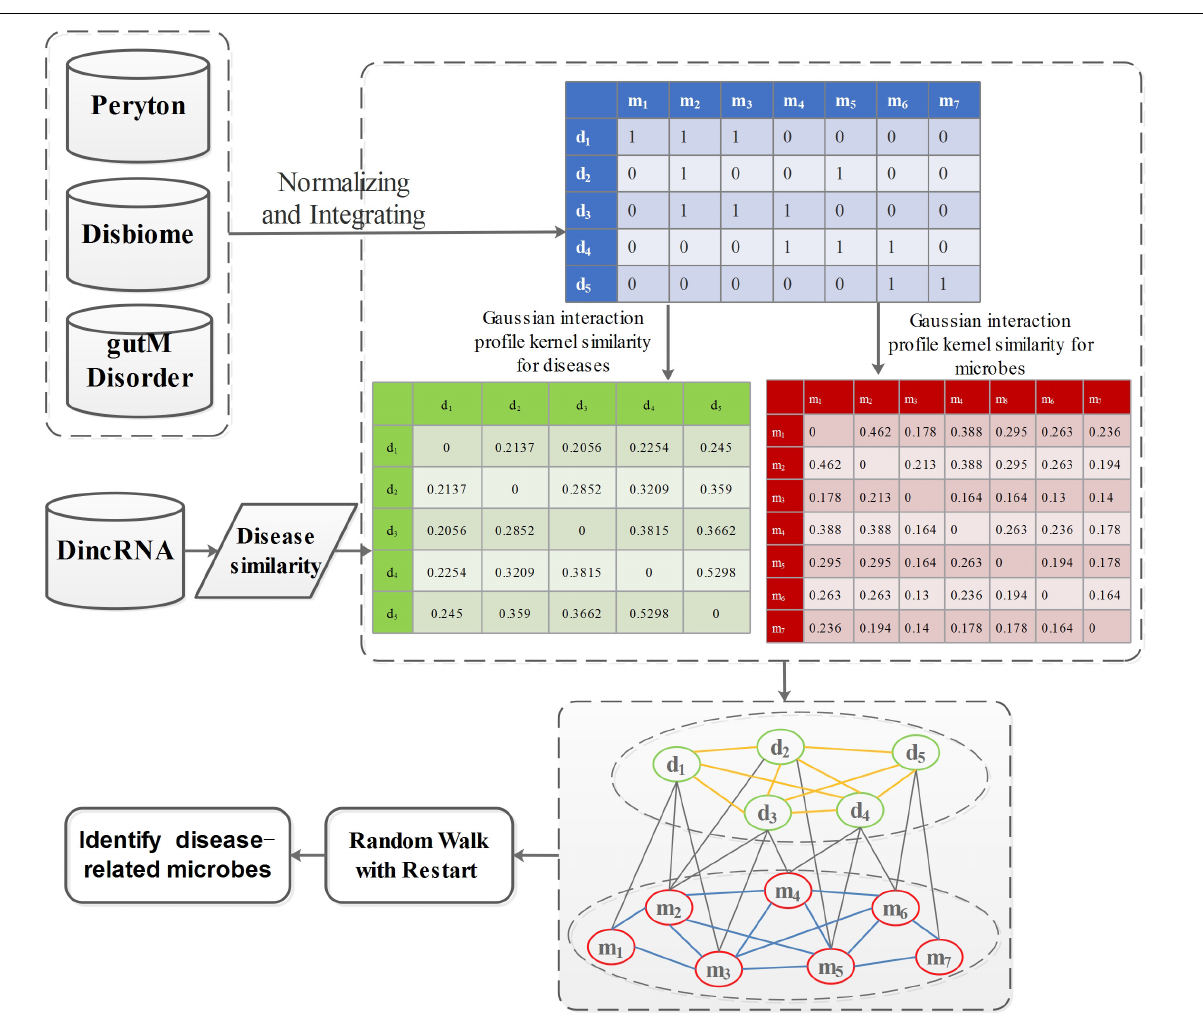
FIGURE 2 | The flowchart of prioritization of candidate disease-related